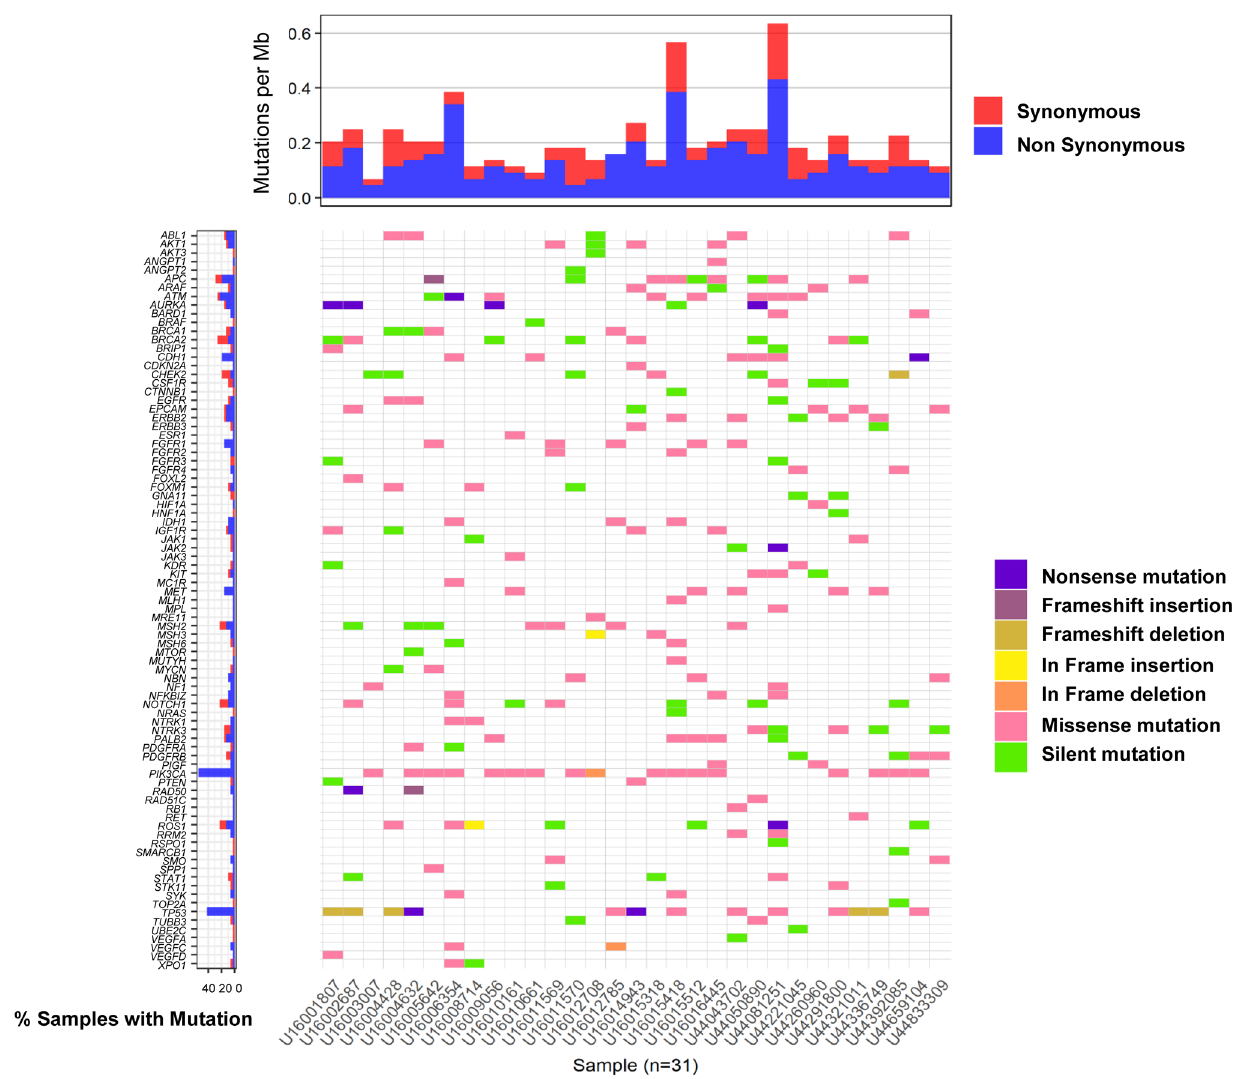
Fig. 1 Genomic landscape represented by angiogenesis and cancer-related genes in 31 breast cancer patients. A total of 198 non-silent (nonsynonymous) mutations in 71 genes were identified. The x column indicates 31 cancer patients, and the y column indicates the 71 genes with 198 non-silent mutations (small color bars except for green). PIK3CA showed the most frequent mutations in breast cancer genomes (16/31, 51.6%). Other recurrent non-silent mutations (≥ 3 cases) were found in 24 breast cancer- or cancer-related genes including TP53 (13 cases), ATM (7 cases), CDH1 (7 cases), APC (6 cases), ERBB2 (5 cases), FGFR1 (5 cases), and MET (5